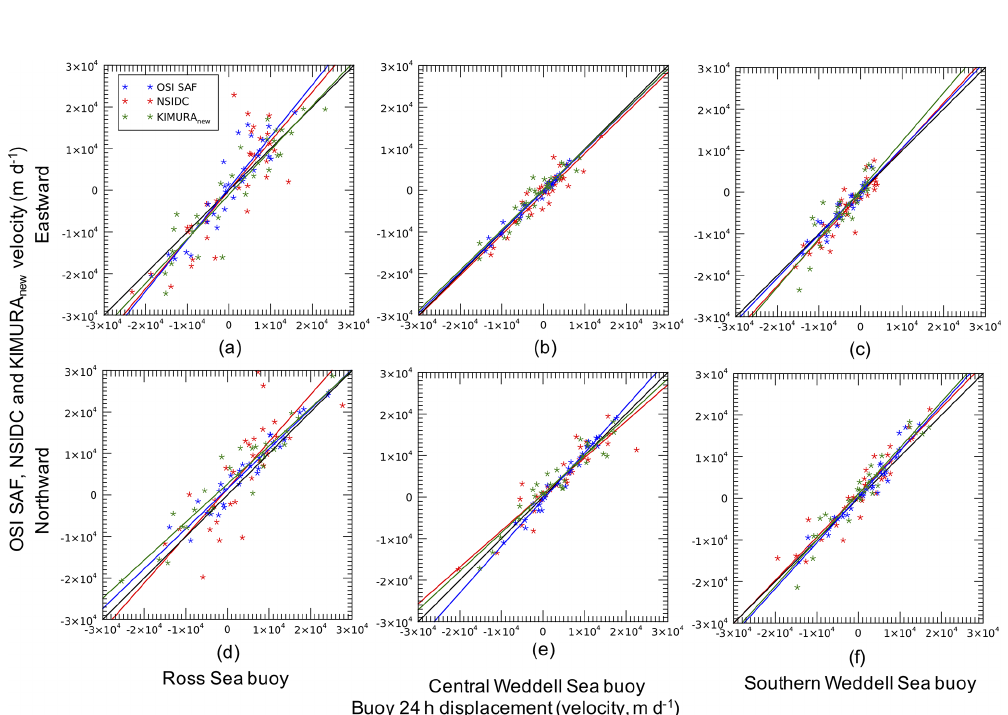
Figure A1. Scatterplot comparison of OSI SAF (blue), NSIDC (red), and KIMURA new combined (green) products against buoy velocities (24h displacement) in eastward ( a , b , and c ) and northward ( d , e , and f ) directions in October 2017 for the Ross Sea buoy, July 2018 for central Weddell Sea buoy, and May 2018 for southern Weddell Sea buoy. The solid black line represents a perfect regression slope of 1.0 with no